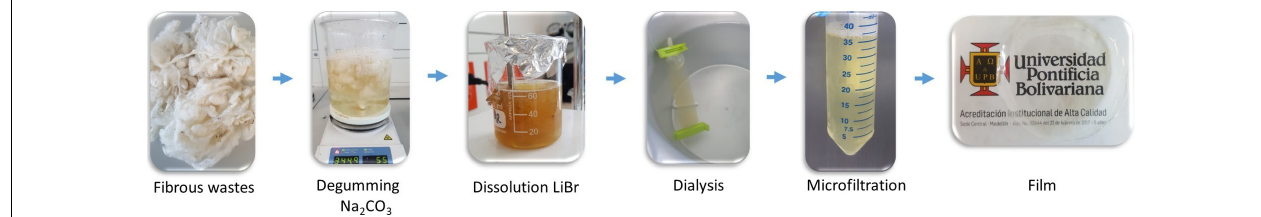
FIGURE 1 | SFW extraction porcess.